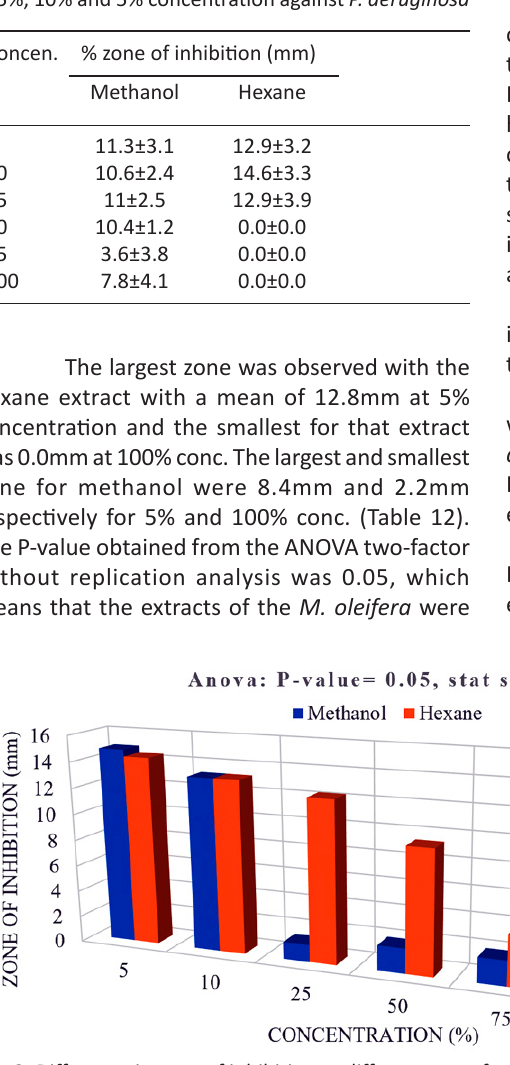
Fig. 2. Difference in zone of inhibition at different conc. for methanol and hexane extract of M.